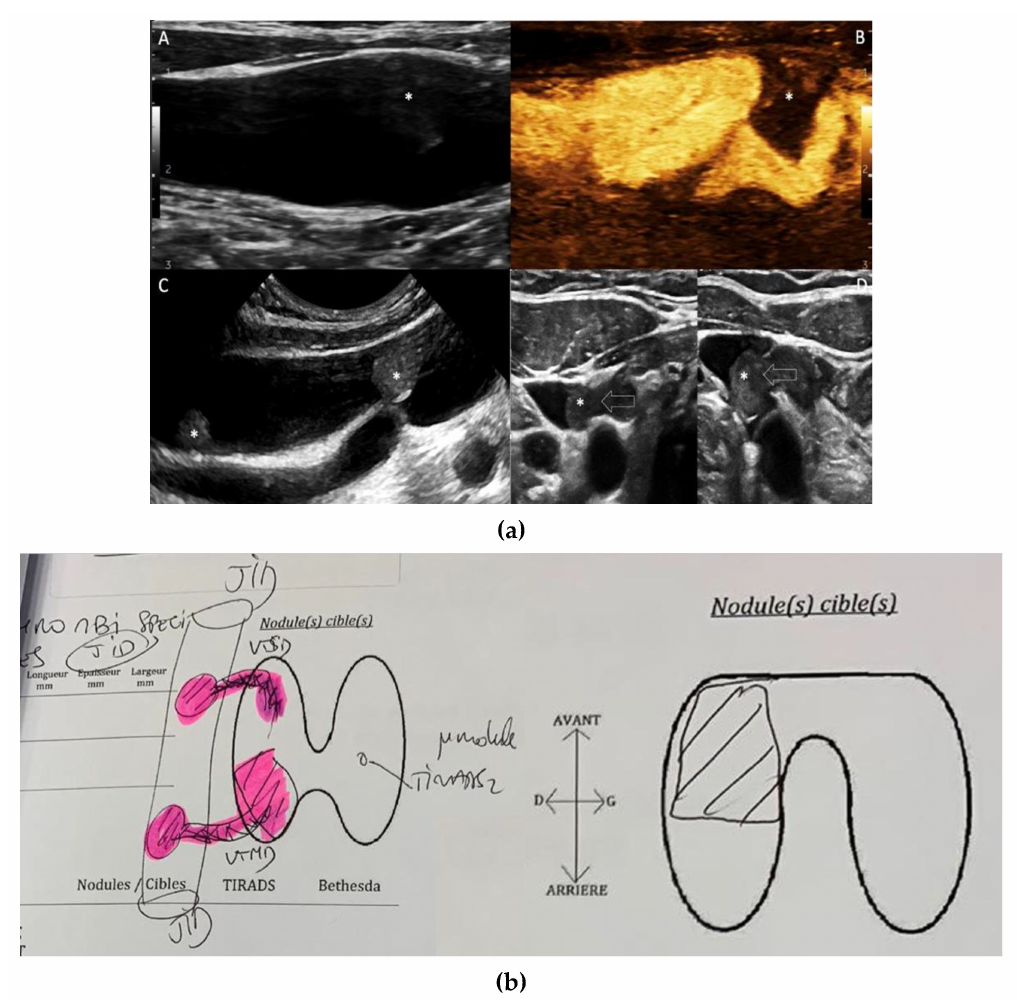
Figure 2. ( a ) Neck ultrasound. A: Sagittal B-mode US scanning of right IJV. Note that intra-venous thrombus (*) is poorly depictable on common settings. B: Sagittal MicroVascular Imaging (MVI) of the right IJV. MVI is a novel imaging technique (reverse color mode) that is more sensitive to depict lower velocities. Tumor thrombus (*) is shown as a black signal void into the IJV lumen (appears in white color). C: Sagittal B-mode US scanning of the right IJV is performed with a higher frequency transducer. Focusing on the IJV clearly depicts two different thrombi located at the mid and lower right thyroid. D: High frequency (16 MHz) axial B-mode US scanning displays enlarged thyroid veins at mid and lower thyroid (arrows), which empty into the ipsilateral IJV. ( b ) Neck ultrasound diagram. Thyroid nodule and bifocal thrombotic invasion of the right